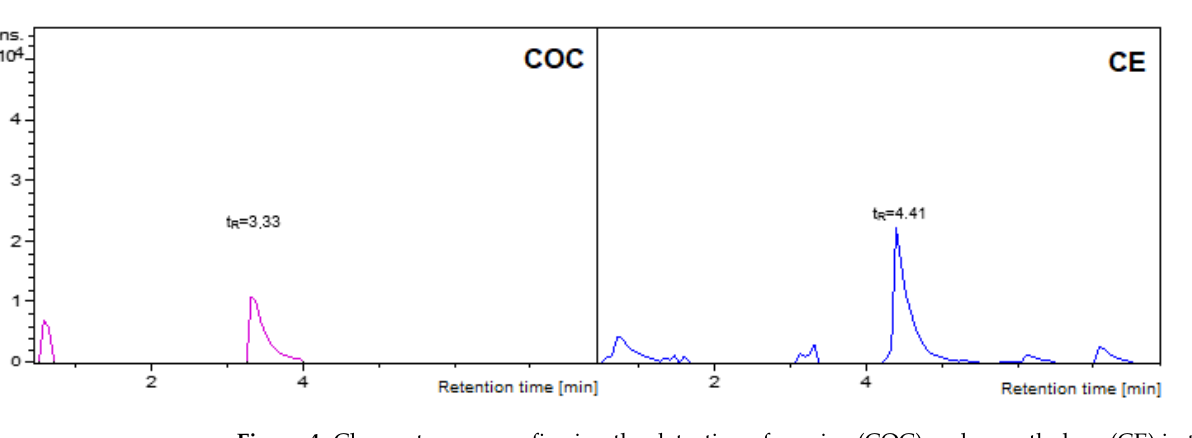
Figure 4. Chromatogram confirming the detection of cocaine (COC) and cocaethylene (CE) in the postmortem case sample tested.